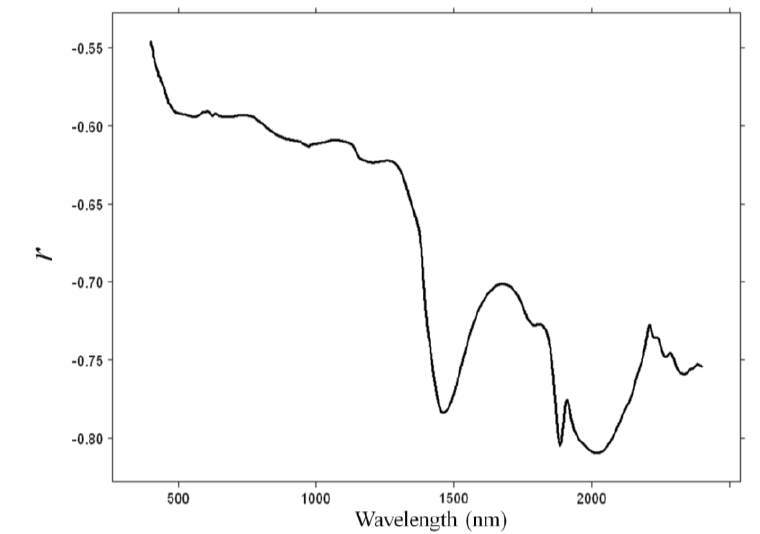
Figure 2. Pearson’s correlation coefficient (r) between soil moisture content and reflectance values of MAC and SOLREFLIU spectral datasets as a function of the